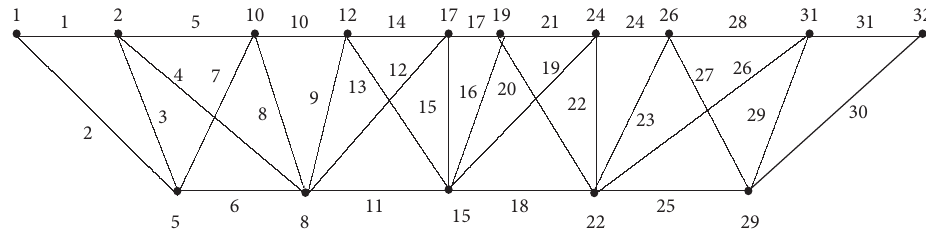
Figure 11: A classical mean labeling labeling of L ( T